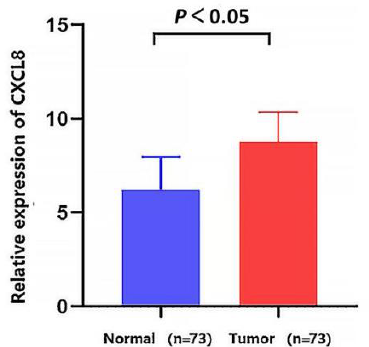
Figure 3. Validation of mRNA expression level of CXCL8 in the GEO database. The mRNA expression level of CXCL8 was up-regulated in ESCC tissues compared with normal tissues ( p < 0.05). p value was calculated using the t -test.